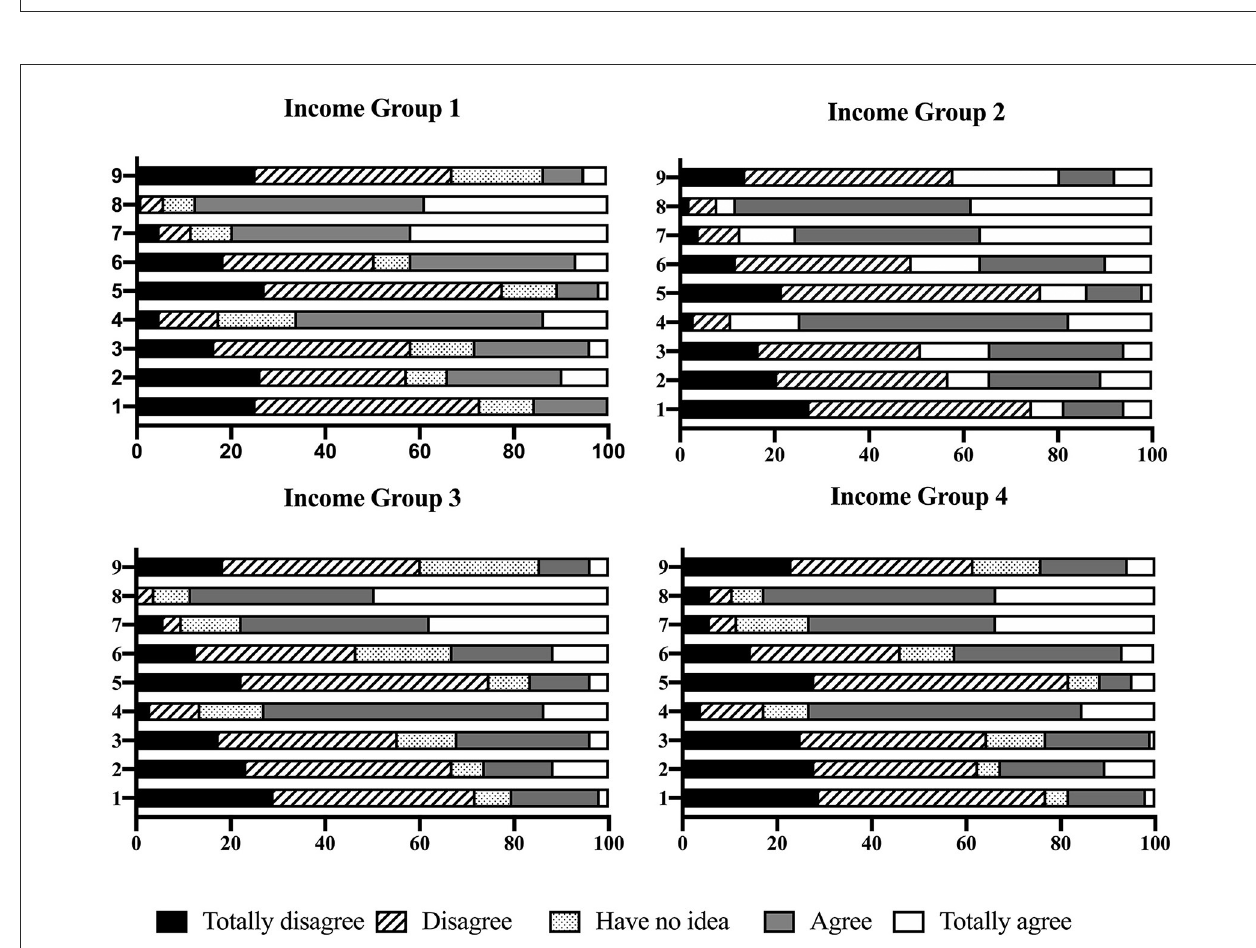
FIGURE2 Agreement level of gender